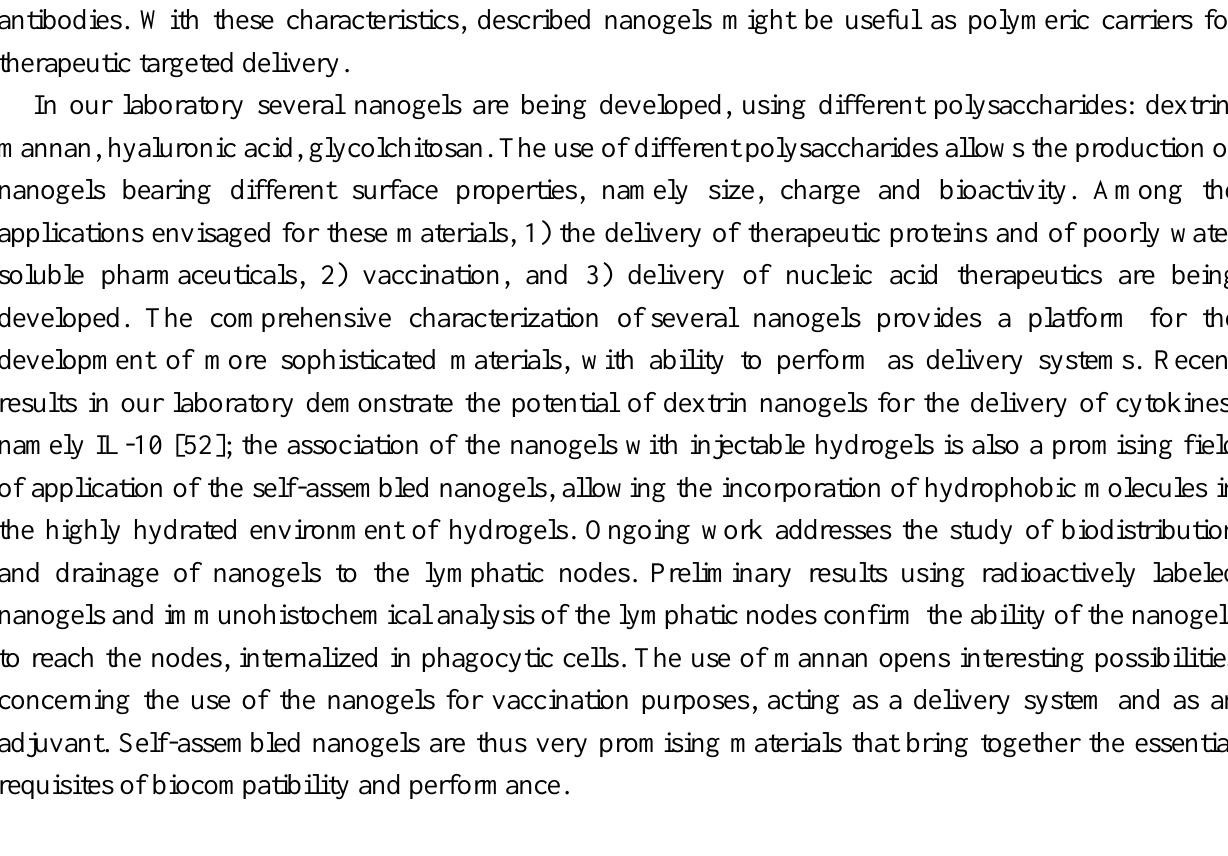
nanogels measured 16